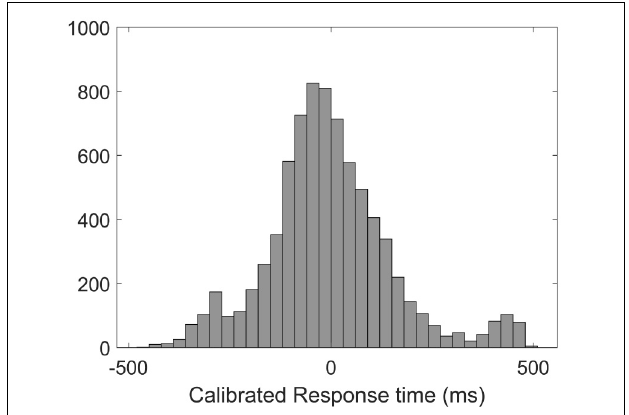
FIGURE 2 | The distribution of the calibrated response times (C-RT).